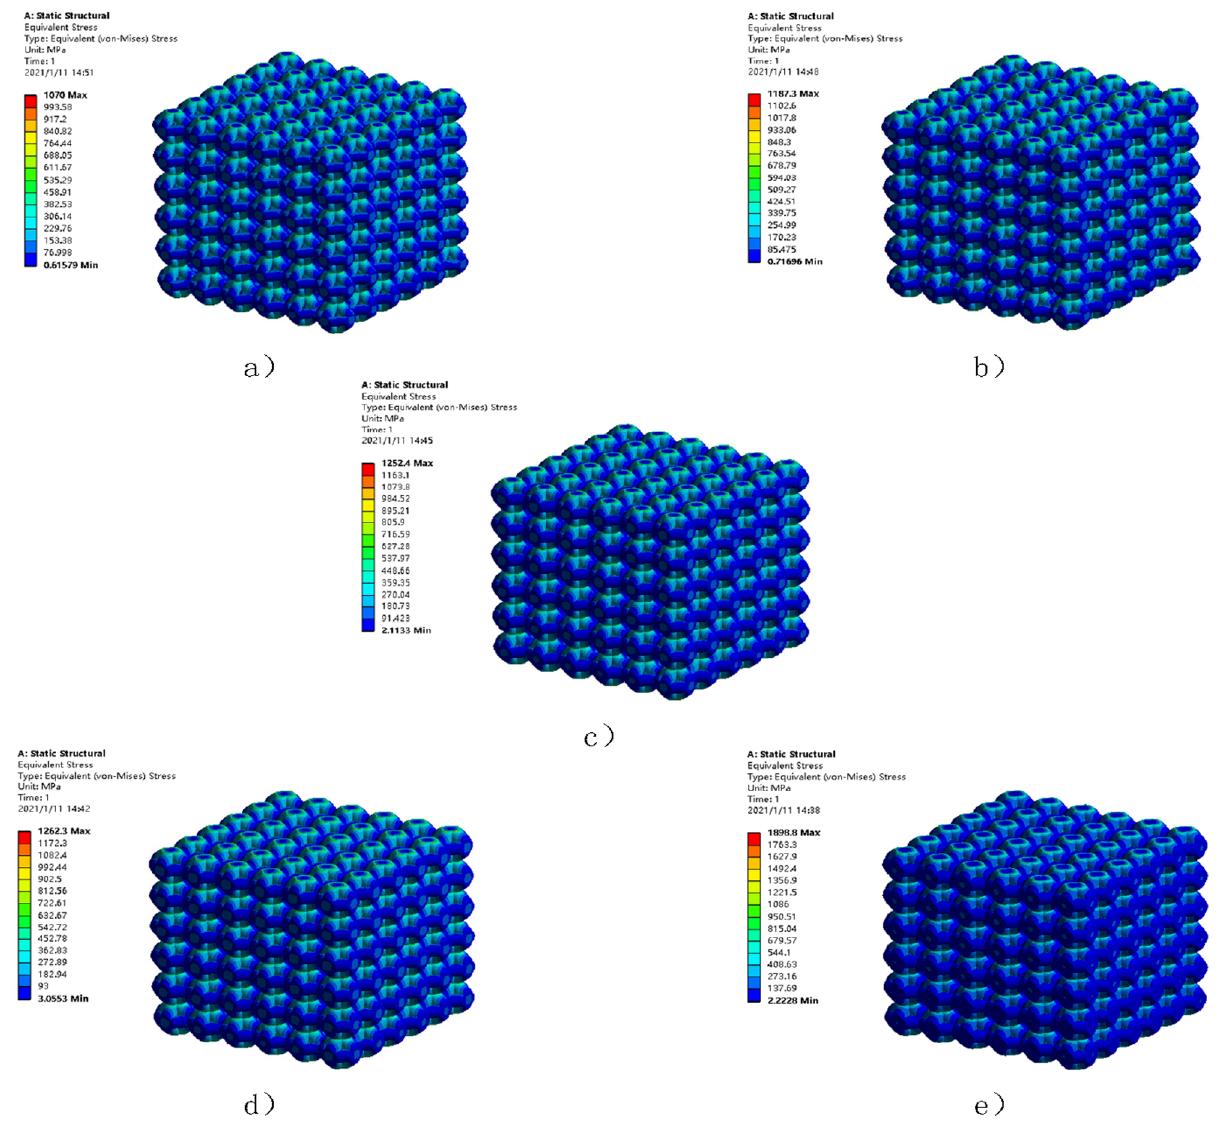
Figure 6: Stress distribution of 2 mm cell loaded with di ff erent edge diameters ( a ) 0.6 mm edge diameter stress map; ( b ) 0.65 mm edge diameter stress map; ( c ) 0.7 mm edge diameter stress map; ( d ) 0.75 mm edge diameter stress map; and ( e ) 0.8 mm edge diameter stress